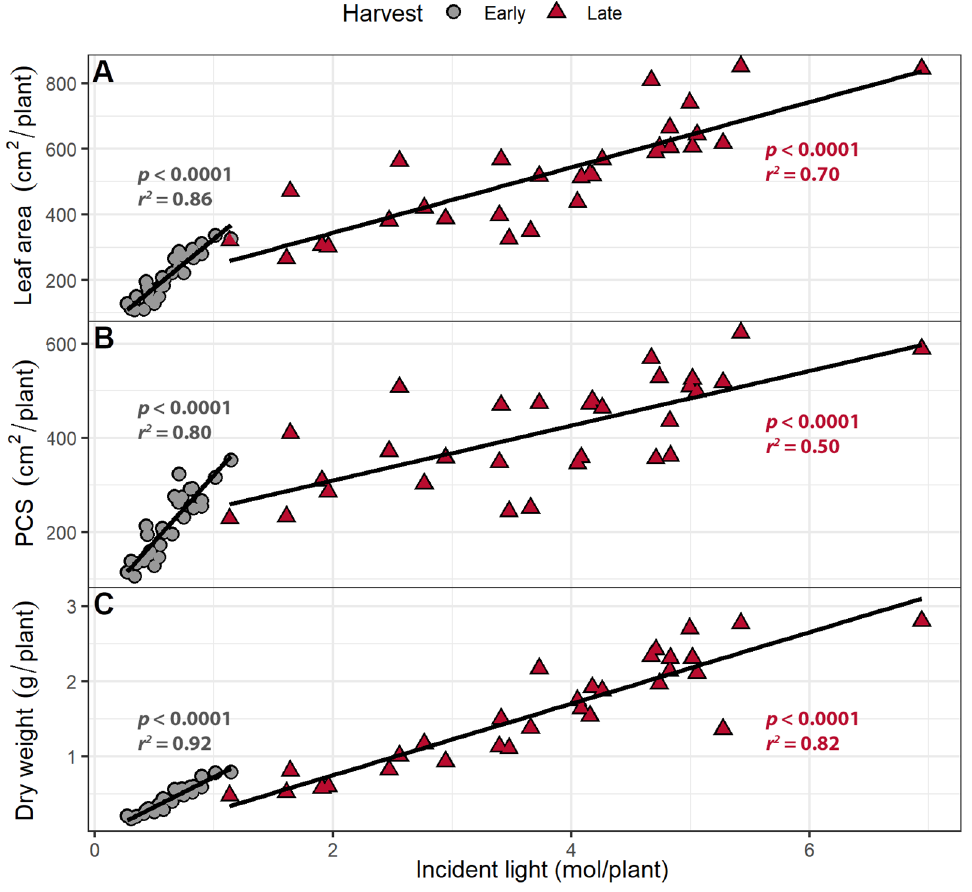
Figure 8. ( A ) The correlation between cumulative incident light (400–800 nm) and leaf area, ( B ) projected canopy size, and ( C ) shoot dry weight. “Green Salad Bowl” lettuce ( Lactuca sativa ) plants were grown under photosynthetic photon flux densities ranging from 111 to 245 µmol m − 2 s − 1 and a perpendicular far-red gradient which ranged from 4.7 to 32.8 µmol m − 2 s − 1 . The early harvest occurred 16 days after germination, while the late harvest occurred 25 days after germination.